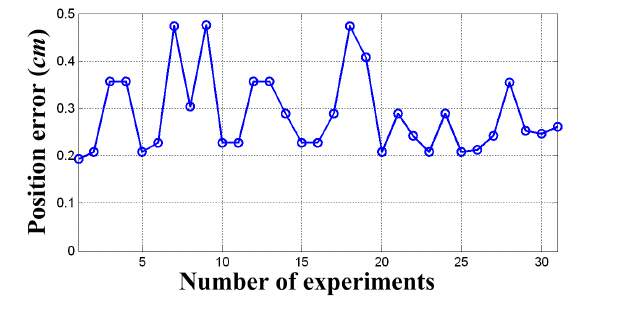
Figure 15. Position error of the initial welding position versus the number of